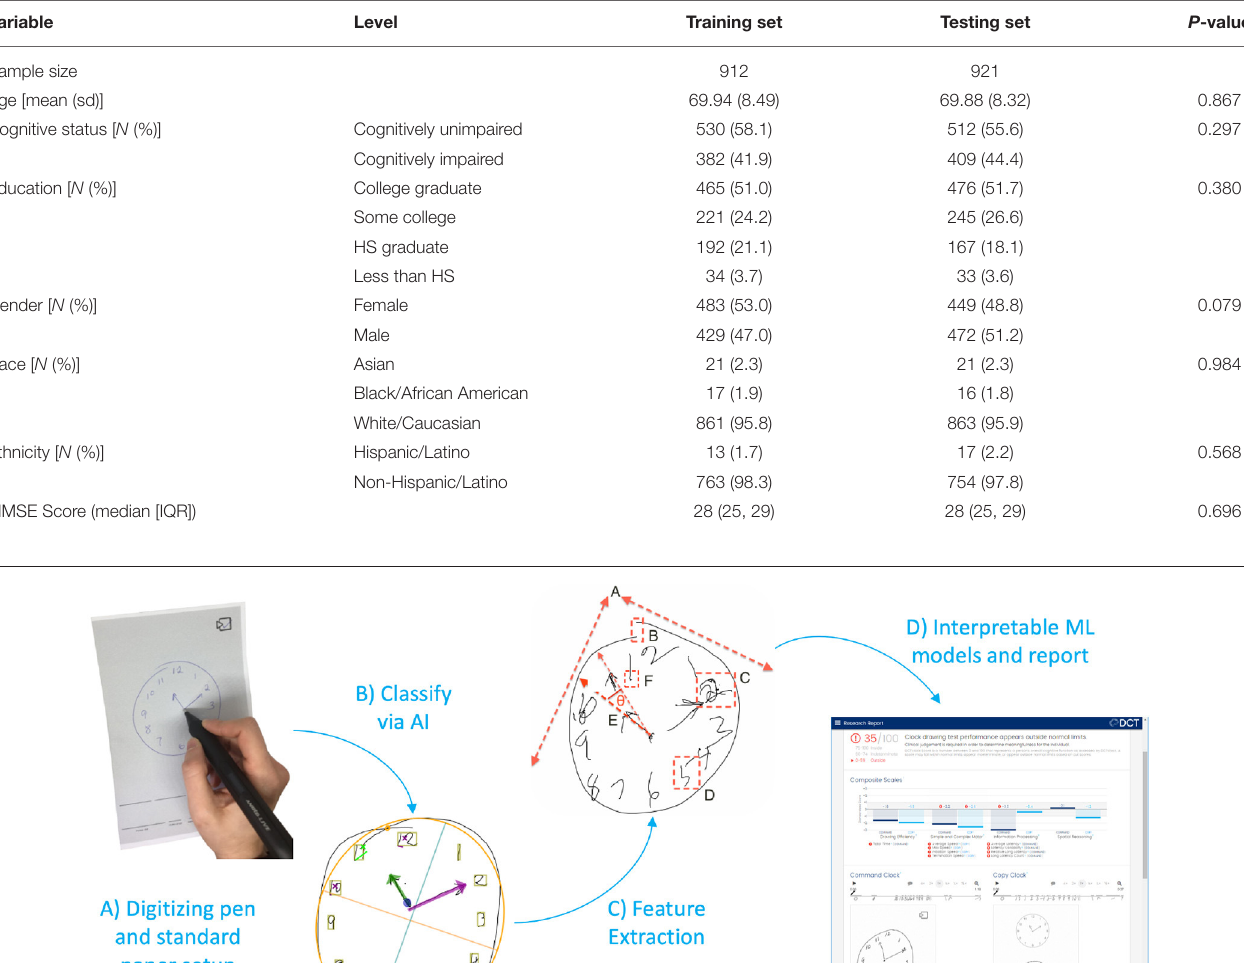
TABLE 1 | Subject demographics for training and testing sets.